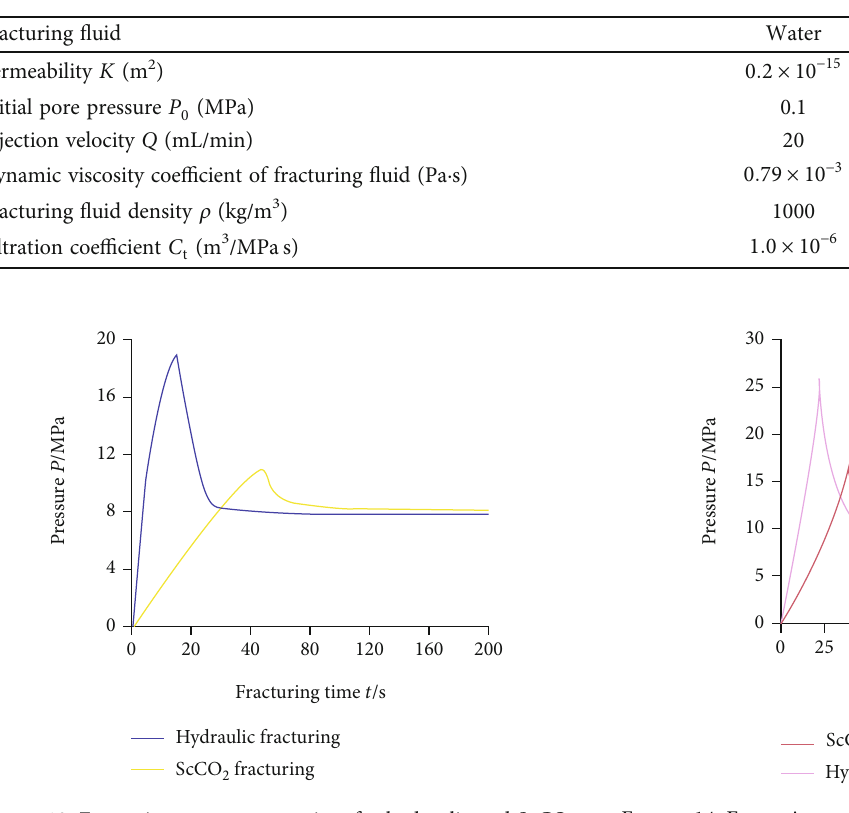
Figure 13: Fracturing pressure over time for hydraulic and ScCO fracturing numerical simulation of coals based on the PPR model.